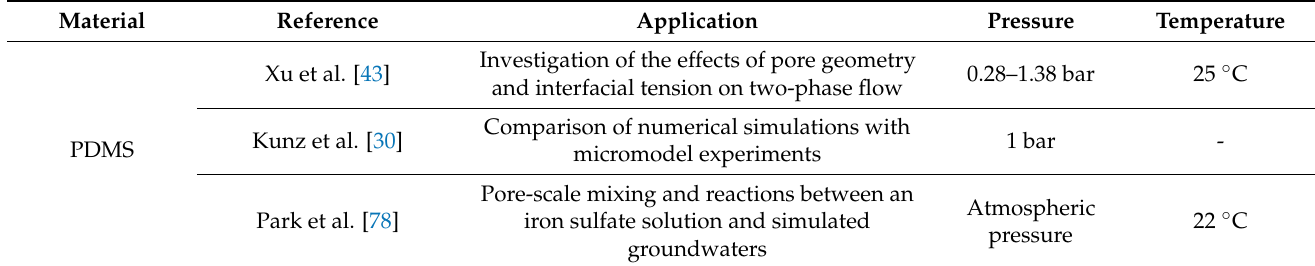
Table 2. Applications and experimental thermodynamic conditions of significant microfluidic works considered in this